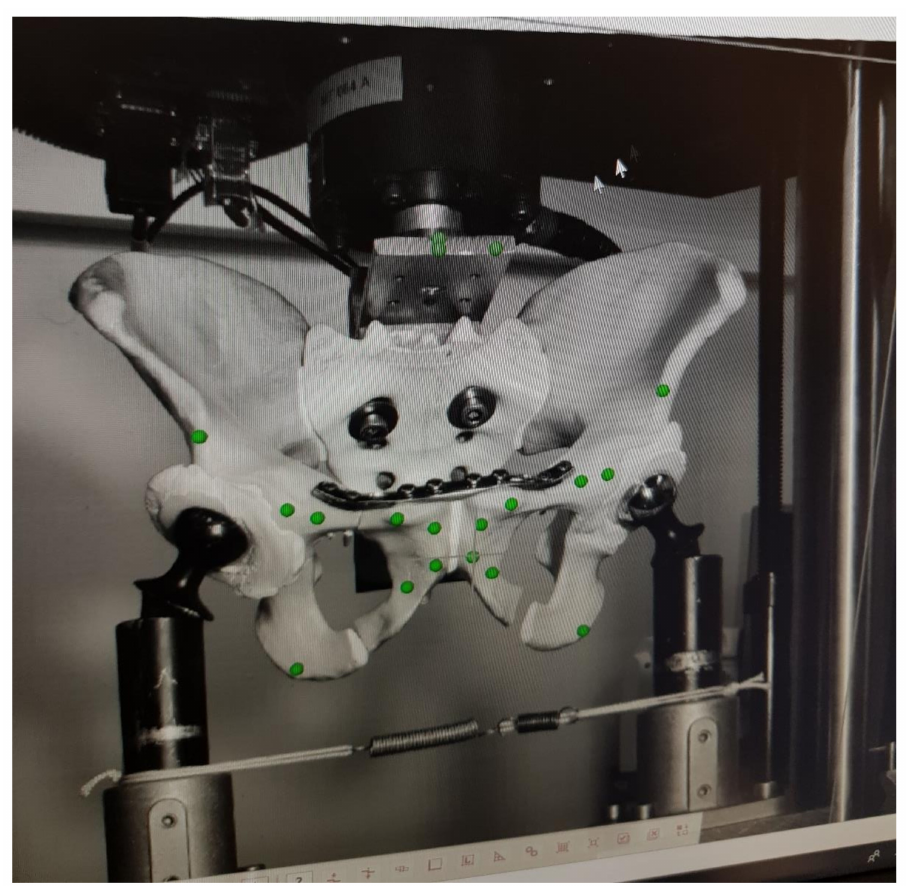
Figure A1. Interfragmentary displacements were continuously measured in all six degrees of freedom using two optical cameras at a rate of 50